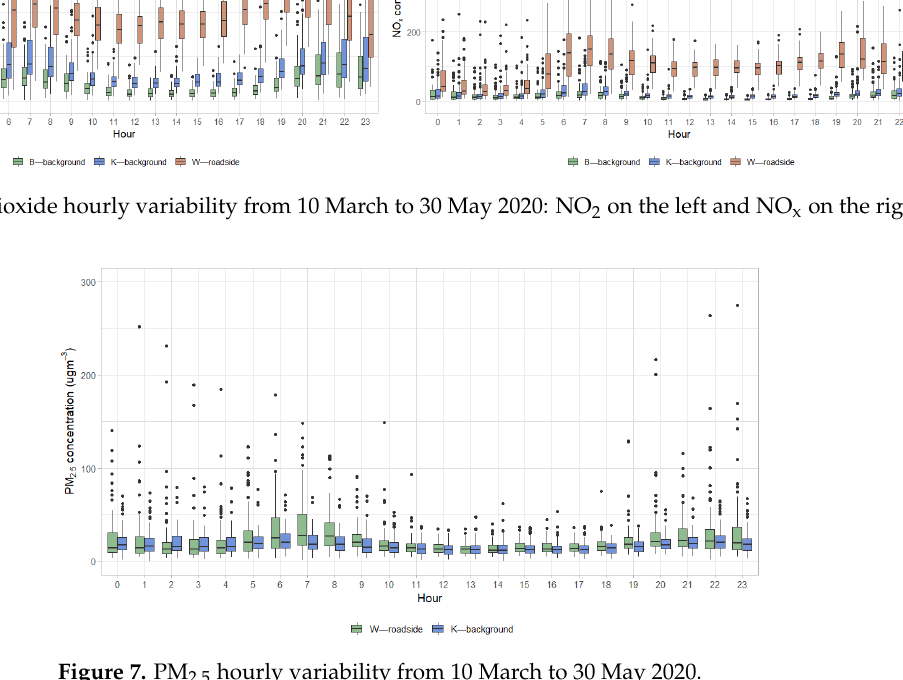
Figure 8. Average daily values of traffic flow.